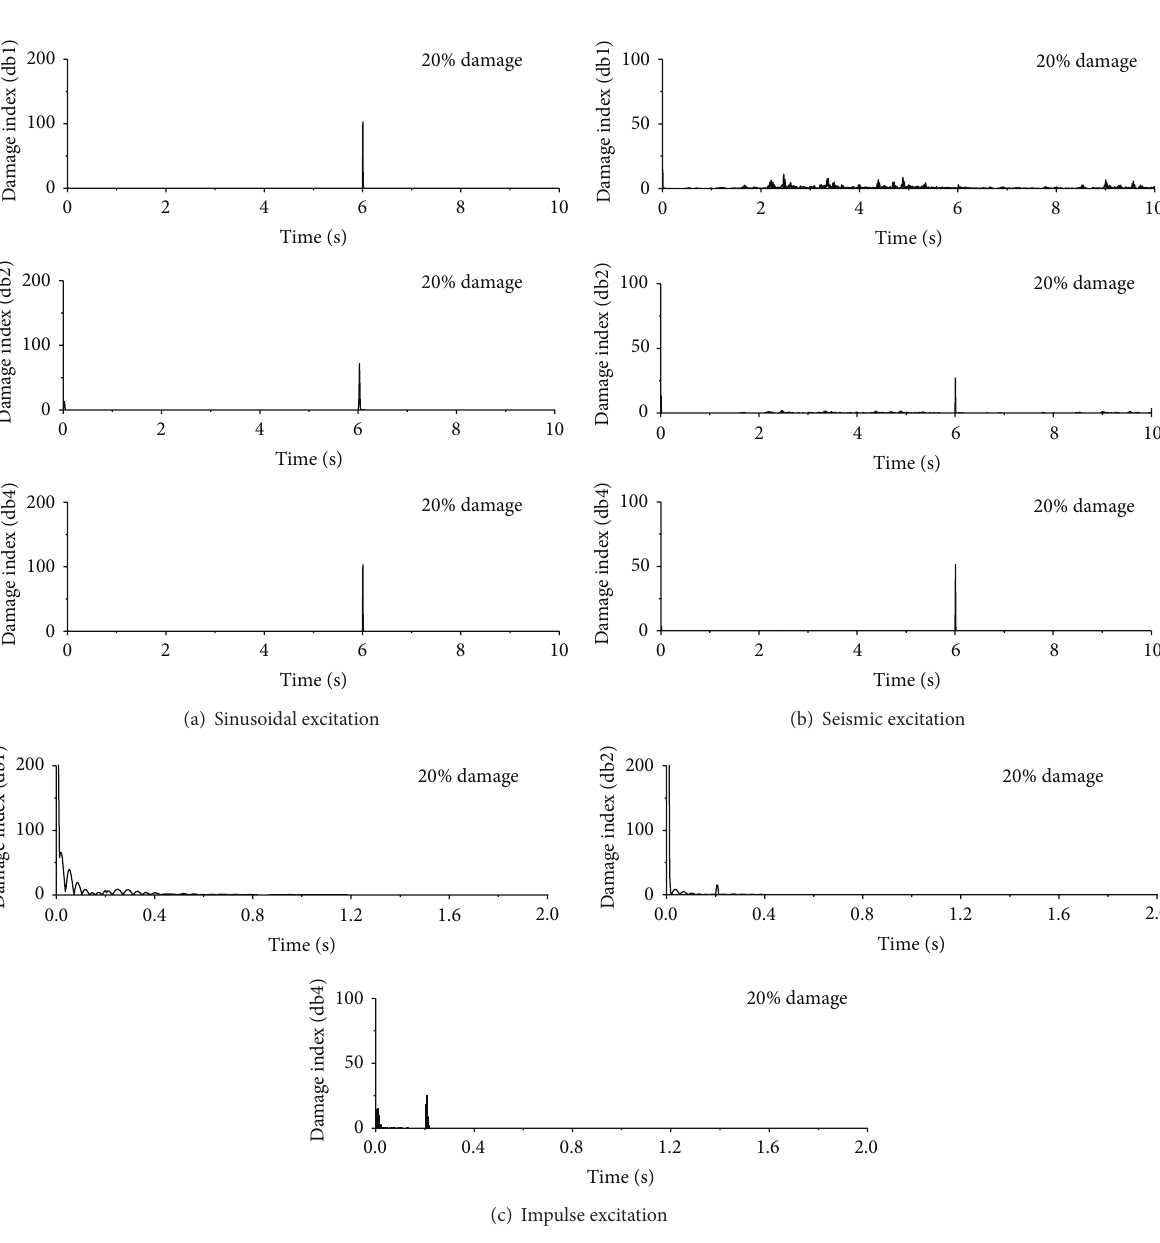
Figure 8: Damage detection using different db wavelets.